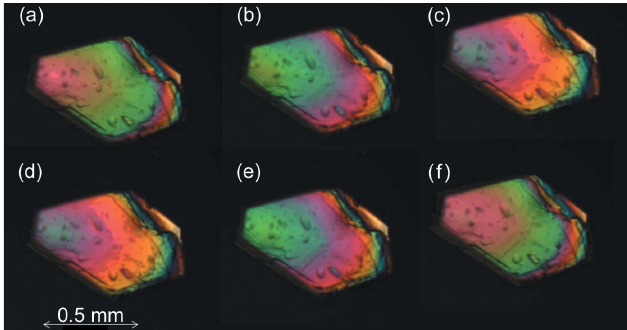
Figure 15 Thermal stage measurements of dl -Hep. ( a )–( c ) IV ! V transition at 401.9, 402.4 and 403.2 K, respectively. ( d )–( f ) V ! IV transition at 402.3, 401.1 and 399 K, respectively. Only color change can be